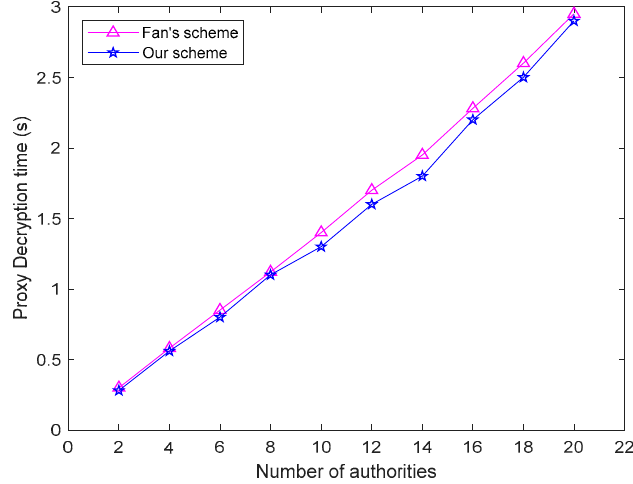
Figure 7. Relation between proxy decryption time and number of authorities.